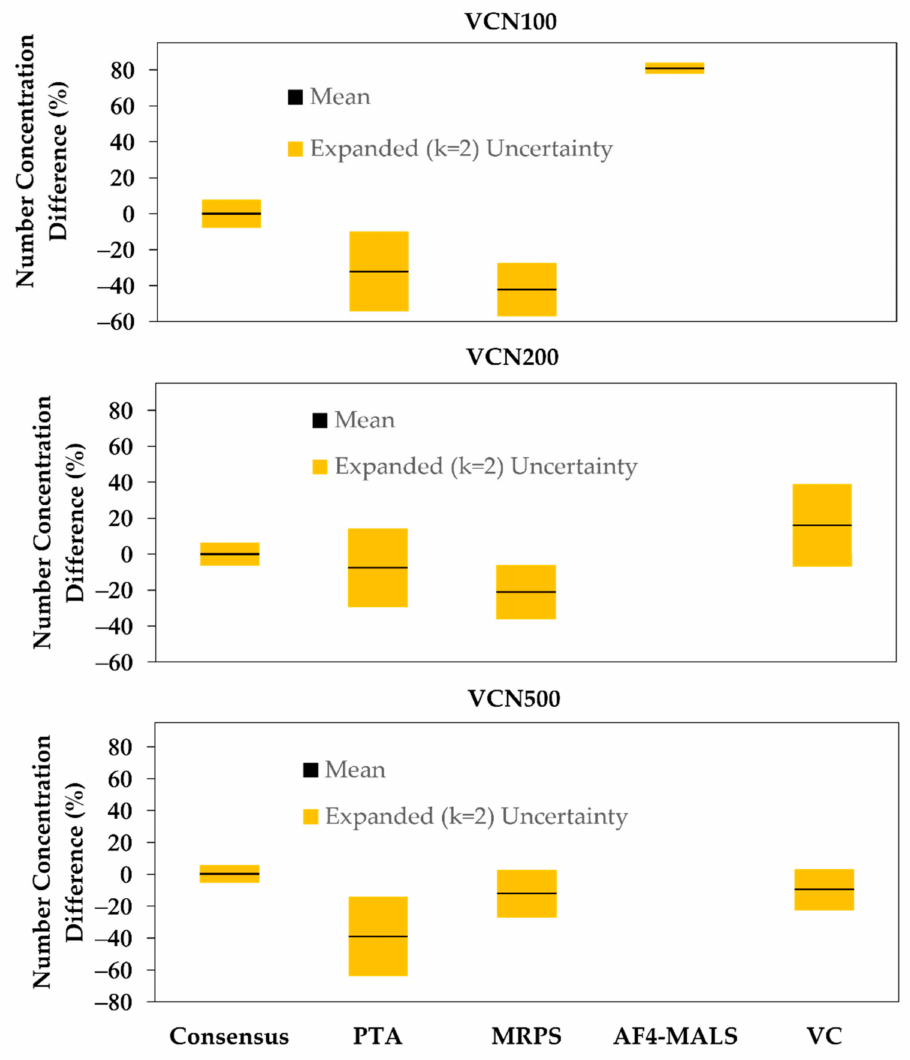
Figure 1. The mean percent difference in measured submicrometer number concentration for each technique relative to the consensus value for the VCNs. The error bars show the estimated relative expanded ( k = 2) uncertainties for the consensus and technique